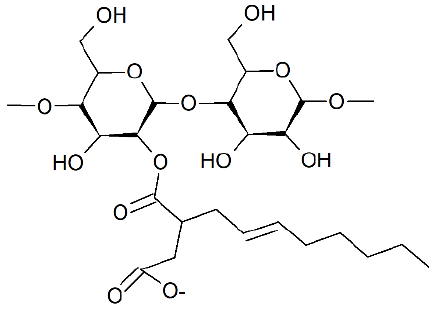
Figure 5. Example of anionic functionalized starch.